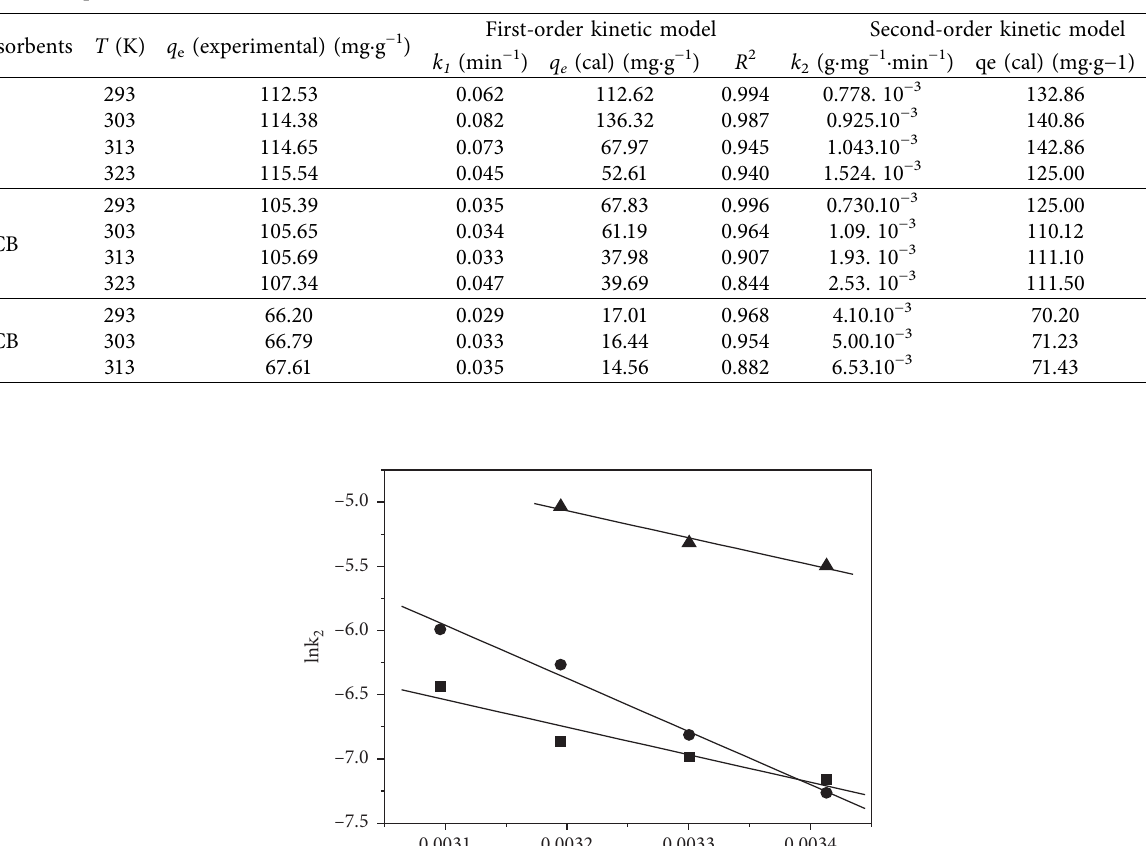
Table 2: Parameters of pseudo-first-order and pseudo-second-order kinetic model of phenol red adsorption by CB, AlCB, and FeCB at different temperatures.